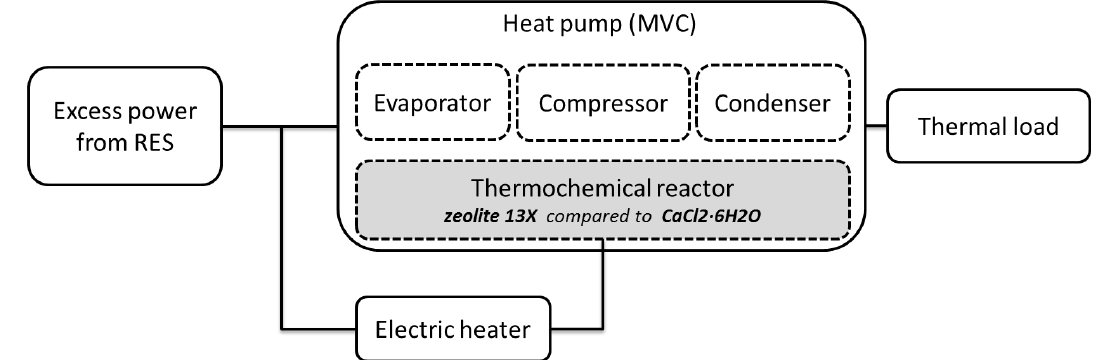
Figure 7. PtH/TCTES system developed by Finck et al. [176]. Figure 7. PtH / TCTES system developed by Finck et al.